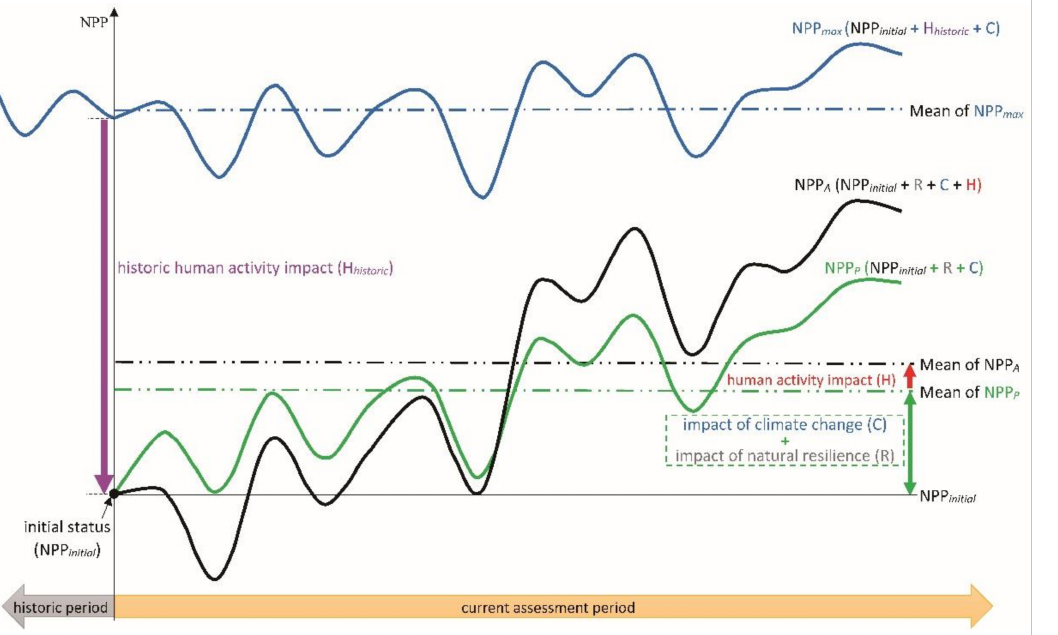
Figure 3. Schematic for the impact of human activities on NPP during the assessment period. Actual NPP series (NPP A ) were the joint results of NPP variations caused by natural resilience (R), climate changes (C) and human activity (H) from initial disturbed status (NPP initial , the black point), as shown by the black curve. Potential NPP series (NPP P ) was the joint results of NPP variations induced by natural resilience and climate changes from the initial disturbed status, as shown by the green curve. Maximum NPP under the constraints of natural condition (NPP max ), as shown by the blue